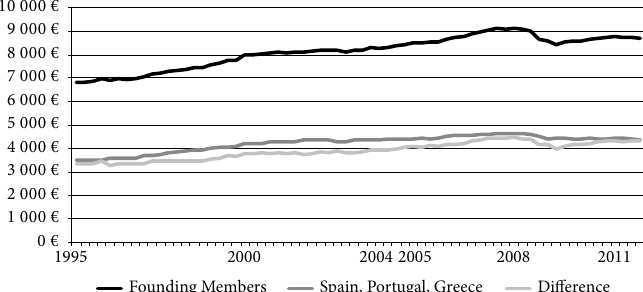
Fig. 5. Convergence in GDP per capita of EU founding members vs. Spain, Portugal and Greece Source : own